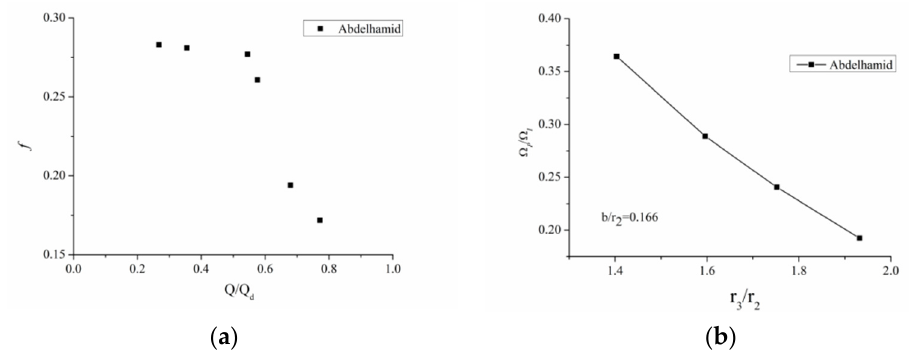
Figure 20. Experiment results of Abdehamid [14]: ( a ) the change in the stall cell propagation velocity with the flow coefficient; ( b ) the change in the stall cell circumferential propagation velocity with the radius ratio under the onset of stall.